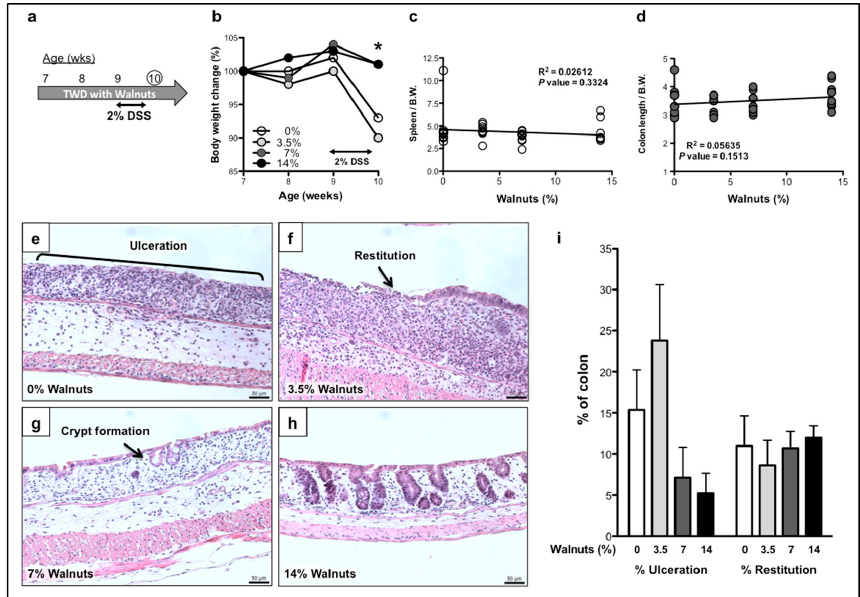
Figure 1. Effects of walnut supplementation on DSS-induced acute colitis. ( a ) Experimental design for the acute phase study. TWD diet supplemented with 0, 3.5, 7 or 14% walnuts was started two weeks prior to the administration of 2% DSS. Mice were sacrificed 2 days after the withdrawal of DSS. The e ff ects of walnut supplementation were examined on the following clinical endpoints: body weight change ( b ), linear-regression analyses of spleen weight ( c ) and colon length ( d ). DSS-induced colonic ulceration ( e ), with signs of restitution ( f ) and crypt formation ( g ). There was significantly less ulceration with 14% walnuts ( h ). Extent of colonic ulceration and restitution were scored as a percent of the entire length of the colon for each group ( i ). Bars represent the means ± SEM n = 9 for 0%, n = 9 for 3.5% and n = 10 for 7% and 14%. * One-way ANOVA with Bonferroni’s multiple comparison